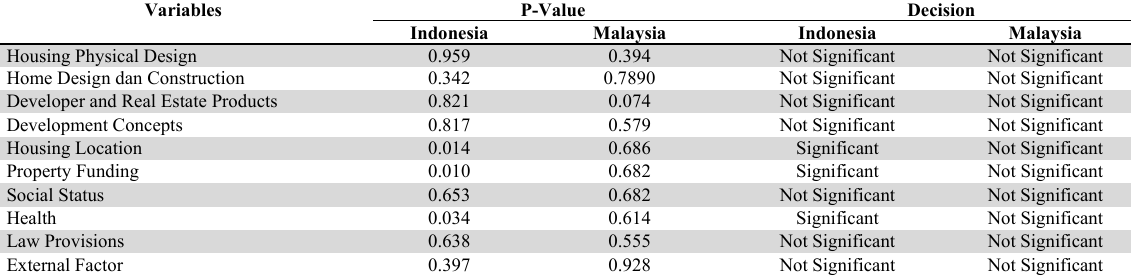
Chi-Square Analysis for Indonesia and Malaysia